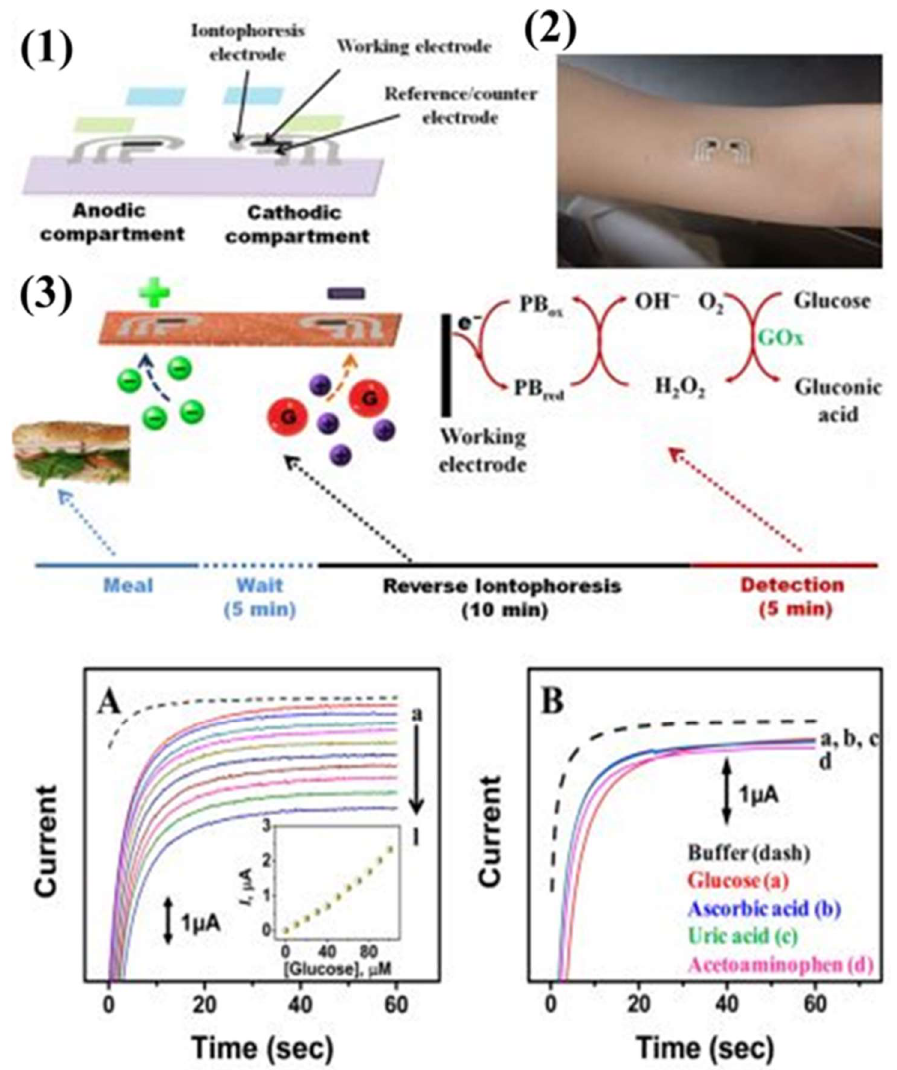
Figure 6. Tattoo-based platform for noninvasive glucose sensing. ( 1 ) Schematic of the printable iontophoretic-sensing system displaying the tattoo-based paper (purple), Ag/AgCl electrodes (silver), Prussian Blue electrodes (black), transparent insulating layer (green), and hydrogel layer (blue). ( 2 ) Photograph of a glucose iontophoretic sensing tattoo device applied to a human subject. ( 3 ) Schematic of the time frame of a typical on-body study and the different processes involved in each phase. ( A ) Chronoamperometric response of the tattoo-based glucose sensor to increasing glucose concentrations from 0 µM (dashed) to 100 µM (plot “l”) in buffer in 10 µM increments. ( B ) Interference study in the presence of 50 µM glucose (plot “a”), followed by subsequent 10 µM additions of ascorbic acid (plot “b”), uric acid (plot “c”), and acetaminophen (plot “d”). Potential step to −0.1 V (vs Ag/AgCl). Medium was phosphate-buffer with 133 mM NaCl (pH 7) [21].